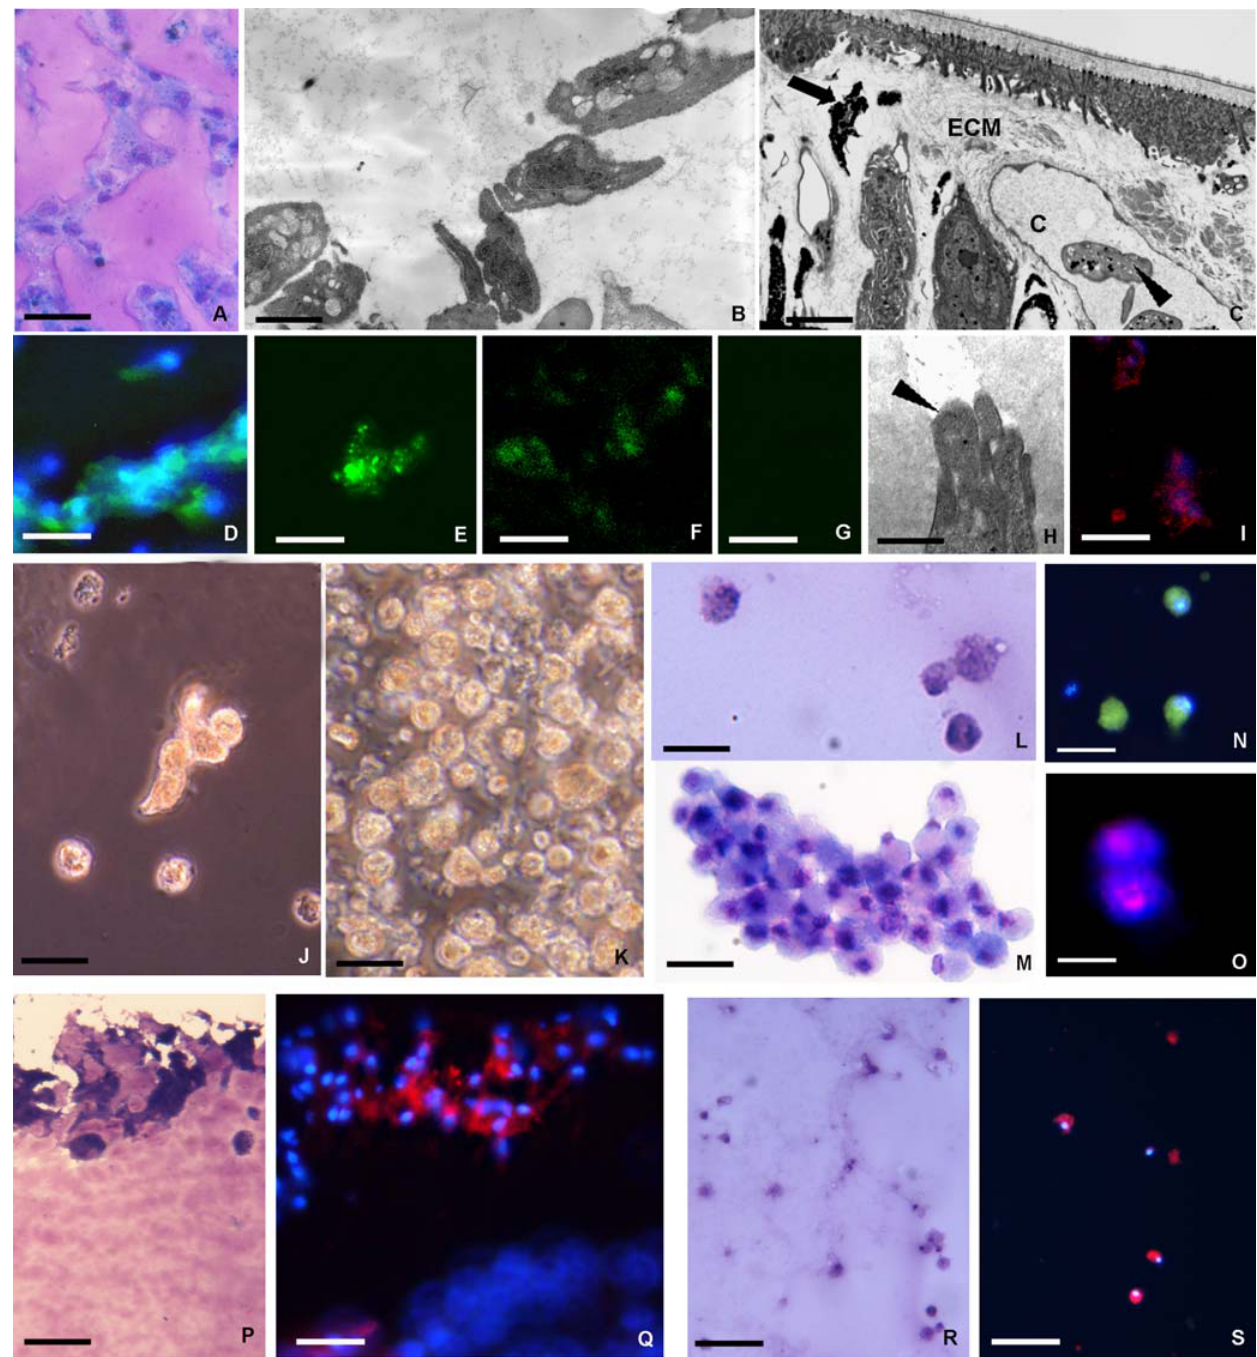
Figure 2. Analysis of the phenotype of cells recruited into the matrigel sponges by VEGF. VEGF induces the mobilization of cells from tissues surrounding the MG implant into the biopolymer that was recovered and processed for structural, ultrastructural immunocytochemical analysis or seeded for cell culture. After 1 week in vivo the matrigel plug contained hematopoietic precursor cells stained with Giemsa solution (A) that were ultrastructurally similar (B) to those localized in capillary (c) and/or in the extracellular matrix (ECM) in stimulated leeches (arrowheads in C). These cells were small in size with large nucleus and scarce cytoplasm (B). Immunocytochemical characterization of cells infiltrating the MG supplemented with VEGF (D–G). The cells expressed several markers typical of hematopoietic/endothelial cells: CD34 (D), CD117 (E), CD31 (F); (G: negative control). The cells showed a migratory phenotype with degradation of ECM that was associated with their cytoplasmic projections (H, arrowhead), were also cathepsin B positive (I). After 1 week in vivo the MG infiltrated with precursor cells was removed and used to seed cell cultures (J–O). Phase-contrast (J, K) and May Grunwald Giemsa staining (L, M) micrographs, obtained 3 days (J, L) and 1 week (K, M) post-seeding, shows the increasing cell numbers from the initially few and scattered (J, L) to growth in clusters (K, M). Immunofluorescence detects expression of CD34 (N), a marker of precursor cells, of the cells label with BrdU indicating that these cells have cycled through S-phase (O). After incubation with Dil-Ac-LDL, those cells thatlocalized in thesuperficial area of MG implant were Giemsa positive (P) took up fluorochrome-conjugated Ac-LDL (Q). Identical results were found within the monolayer of these cultured cells that were Giemsa and DIL positive (R, S). Taken together, these results strongly indicate that the cells migrating into the MG in vivo growing out in vitro consisted essentially of precursor/endothelial like cells. Bars: A 20 m m; B 2 m m; C 4 m m; D-N, P, Q 10 m m; O 5 m m; R, S 50 m m. doi:10.1371/journal.pone.0001910.g002 PLoS ONE |